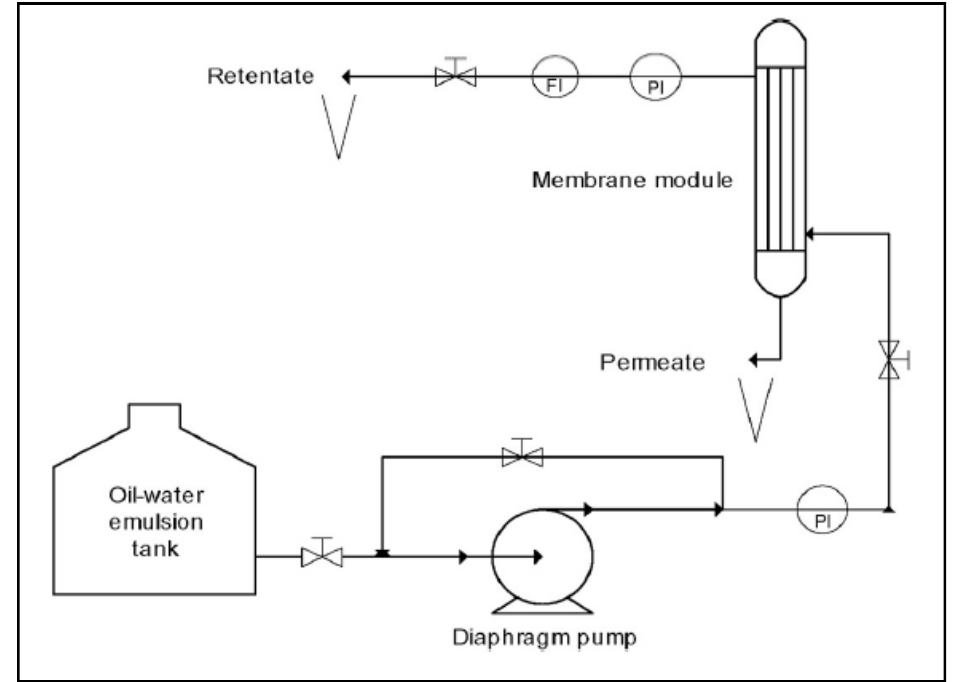
Figure 3. Schematic diagram of the experimental set-up. Reprinted with permission from ref. [34]. © 2020 Elsevier Ltd.